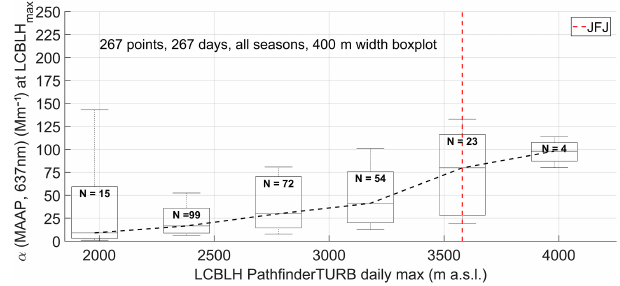
Figure 7. Box plot showing the relation between the absorption co- efficient at 637nm measured by the MAAP at the JFJ versus the LCBLH retrieved by PathfinderTURB for the period September 2014 to November 2015. The boxes show the median (within the box), the interquartile range (upper and lower box boundaries) and the 15.87–84.13 percentile range of α values